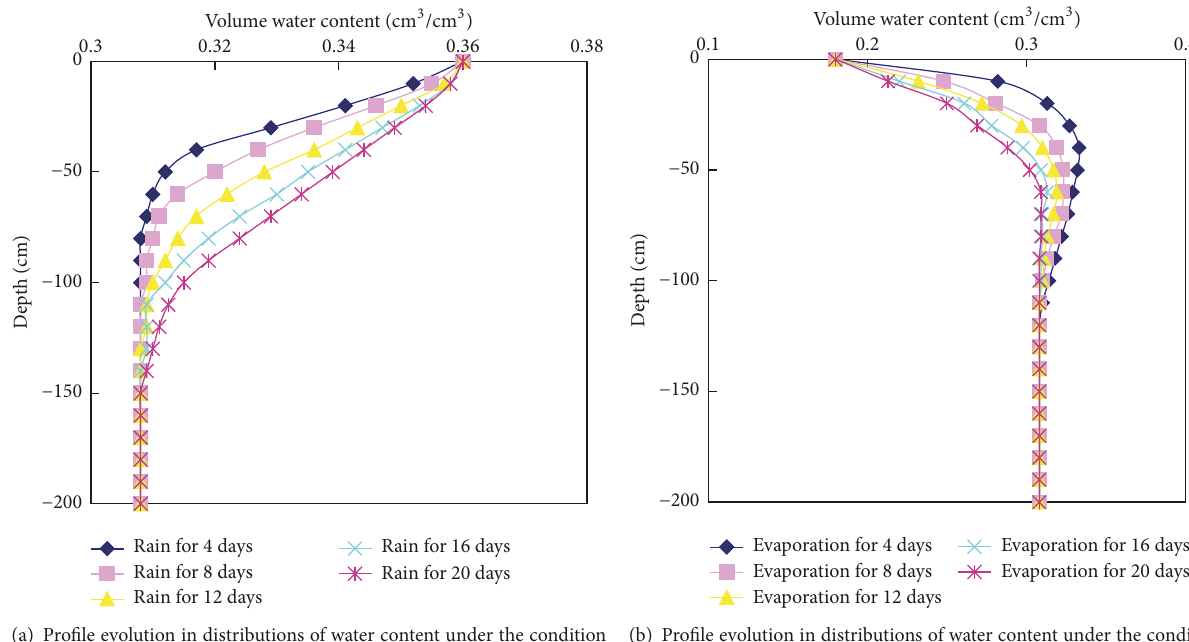
Figure 5: Distributions of water content under conditions of continuous rainfall and evaporation.